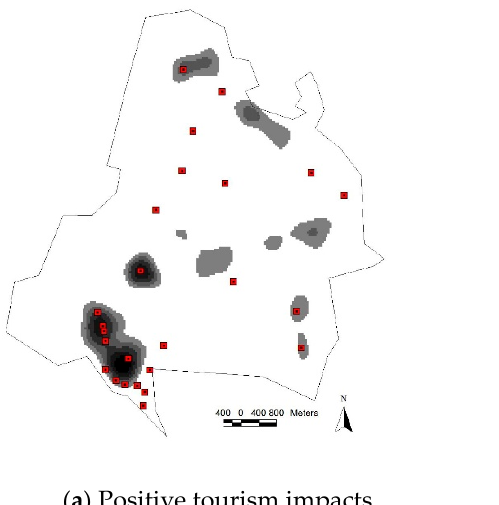
Figure 4. Geographic density of tourism impacts. Note: The dark-colored areas indicate dense tourism impacts depending on the mean of the tourism impact items; the square areas indicate the tourism